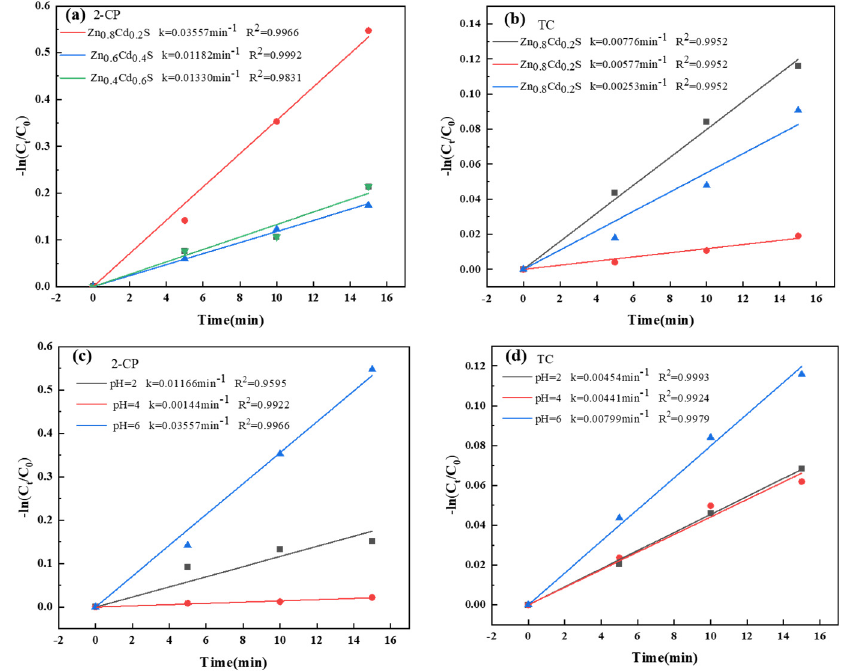
Figure 7. The Kinetic fitting curves. ( a ) The Kinetic fittings of 2-CP. ( b ) The Kinetic fittings of TC. ( c ) The Kinetic fittings of 2-CP, HCl adjust pH. ( d ) The Kinetic fittings of TC, HCl adjust pH.